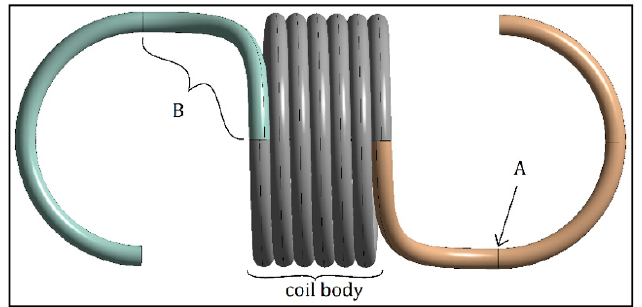
Figure 2. Extension spring critical points.